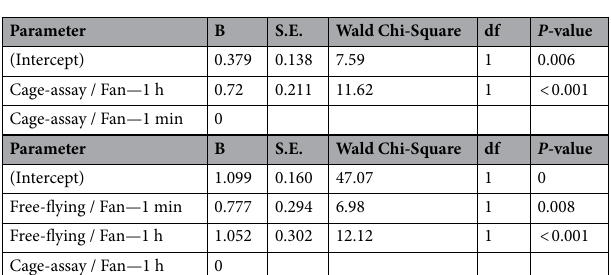
Figure 5. Dual-cage approach validation for screening mosquito against aerosolized insecticides. Dependence of mortality rates of susceptible and resistant ( a ) Ae. aegypti, ( b ) An. gambiae on cage structure and location in the chamber. ( c ) Impact of fan airflow duration on mortality in dual-cage and free-flying assays. ( d ) Summary of the space grid mapping of mosquito knockdown distribution in the presence/absence of fan airflow. Error bars represent 95% confidence intervals. S-cage (Standard cage) and D-cage (Dual-cage) are cages with and without an internal wall, respectively. Cage—number and letter; numbers represent the cage’s clockwise location in the Peet-Grady windows and letters—A and B, dual-cage left or right half.